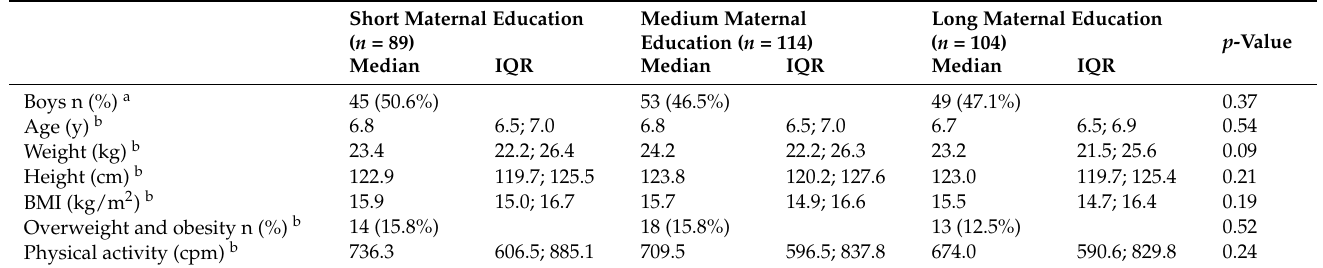
Table 2. Pre-intervention characteristics of the participants by